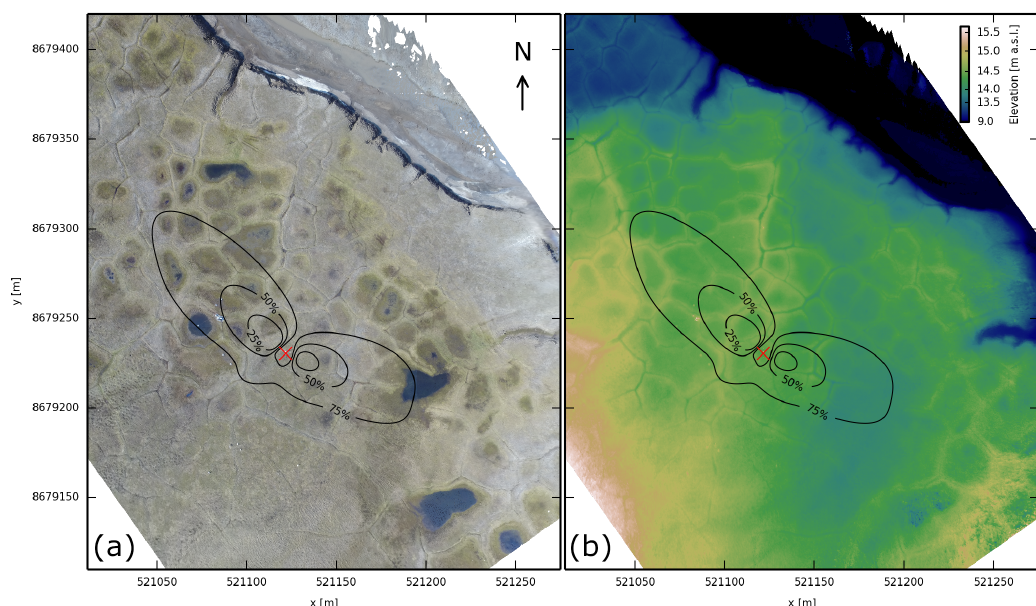
Figure 1. Map of the site in Adventdalen (coordinates in UTM zone 33X). The red cross marks the EC tower, around which the contour lines indicate the area’s relative contribution to the EC signal (footprints) averaged over June 2015. Six automatic flux chambers are located in the NW footprint (bright dots). (a) Ortho-rectified aerial photograph from the end of June 2015. (b) Corresponding surface elevation with an estimated vertical uncertainty of